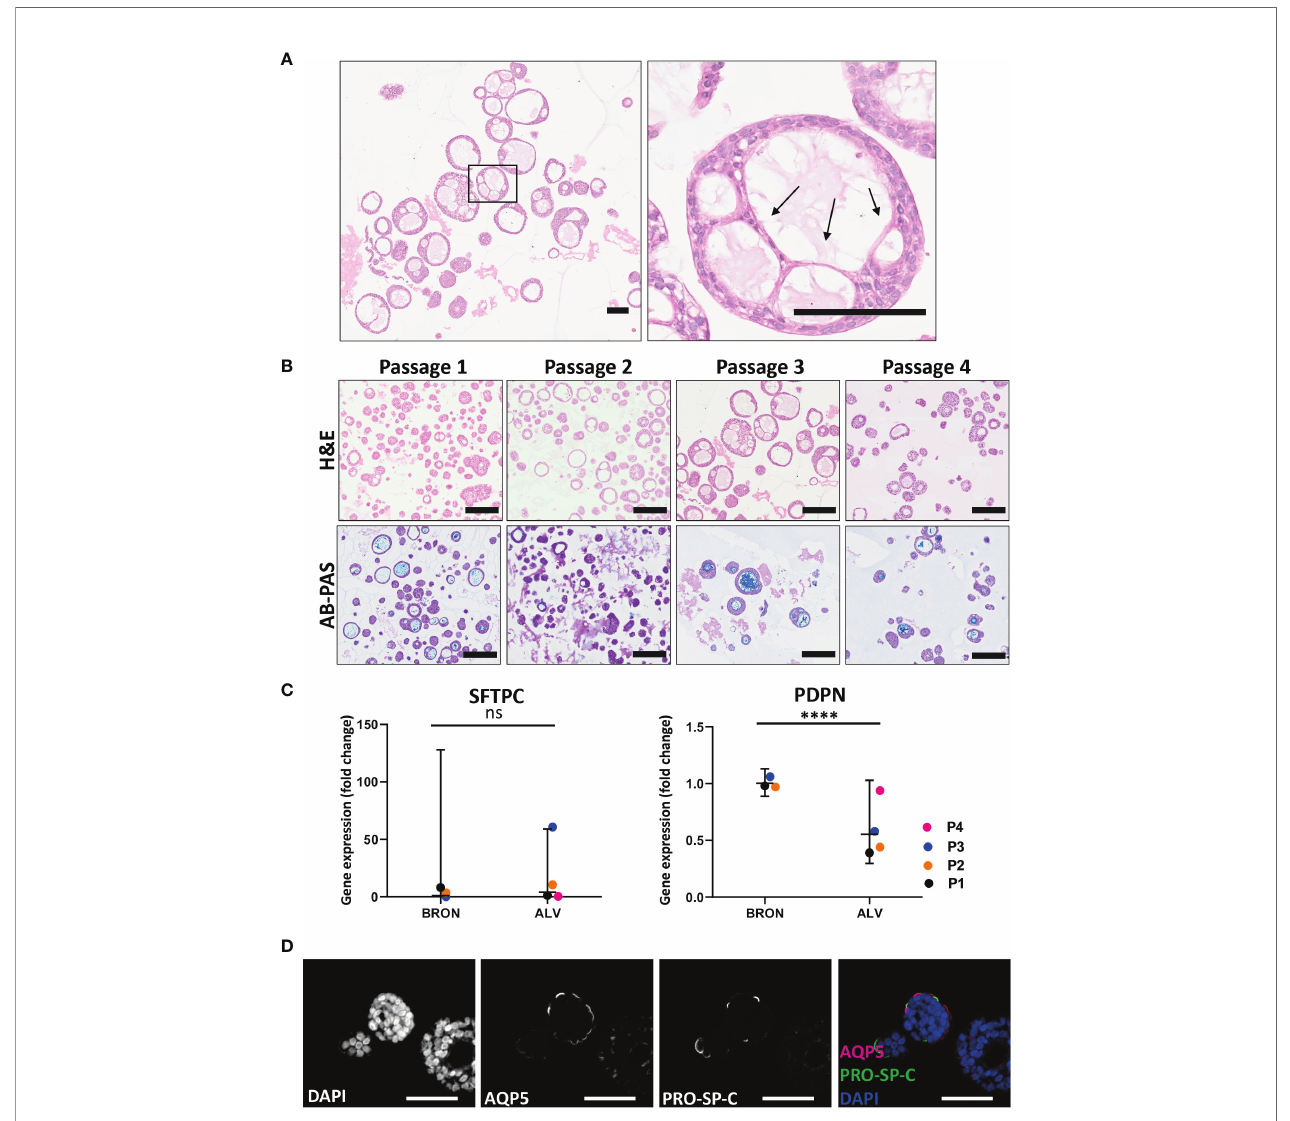
FIGURE 4 | Functional and phenotypic characterization of airway organoids of alveolar differentiation (ALV). (A) The morphology of thin-walled cells detected in the H&E-stained alveolar sections resemble the morphology of AT1 cells. Scale bar equals 100 µm. Black arrows point at the thin-walled cells displaying characteristic AT1 morphology. (B) Hematoxylin and eosin (H&E) (upper row) and alcian blue-Periodic acid schiff (AB-PAS) (lower row) stained FFPE sections of alveolar organoids over the four passages (Passage 1- Passage 4). Scale bar equals 200 µm. (C) Fold changes in gene expression levels of the type 2 pneumocyte (AT2) cell-type marker SFTPC and the type 1 pneumocyte (AT1) cell-type marker PDPN, in the organoids cultured in alveolar medium, that were passaged 4 times (P1-P4). Relative quanti fi cation was performed using the Livac method and alveolar organoids are normalized to the average delta Ct of bronchiolar organoids. The mean value of three technical replicates for each passage are shown as individual data points. GraphPadPrism v9 was used to calculate and display the geometric mean and 90% con fi dence interval of the biological replicates (passages). Statistics were performed on the delta Ct values using the Mann-Whitney test. Expression of SFTPC were 3.90 fold higher in ALV than BRON. (ns). There is a signi fi cant difference (fold change 0.55, **** P = 0.0001) in the expression of PDPN gene between the alveolar and bronchiolar organoids, the gene expression pro fi le shown here are from patient L2. (D) Immuno fl uorescent staining of formalin fi xed paraf fi n embedded (FFPE) sections of alveolar organoids showing Aquaporin 5 (AQP5) as a marker for AT1 and pro-surfactant protein C (PRO-SP-C) as a marker for AT2 cells. Scale bar equals 50